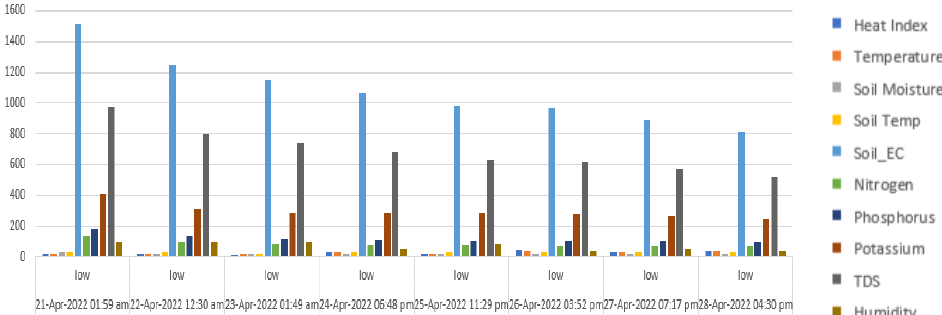
Figure 1. Real-time data of soil condition in the lemon orchard and fertilizer trend that helps in optimum inputs. optimum